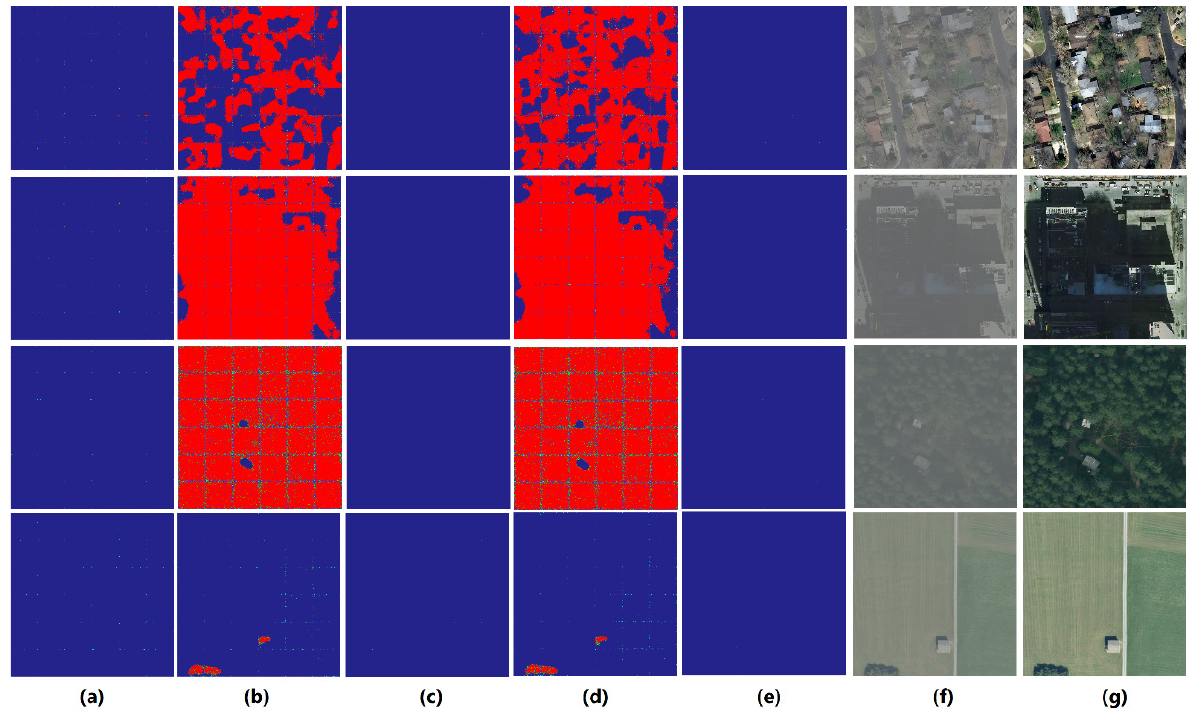
Figure 9. Three-step DRL_Dehaze result at a uniform-haze scale in various areas. ( a ) First action maps, ( b ) second action maps (at the beginning of the DRL training process), ( c ) second action maps (when the DRL training has advanced), ( d ) third action maps (at the beginning of the DRL training process), ( e ) third action maps (when the DRL training has advanced), and ( f ) hazy aerial images, ( g ) dehazed clear aerial images (action ( a , c ) maps are adopted).